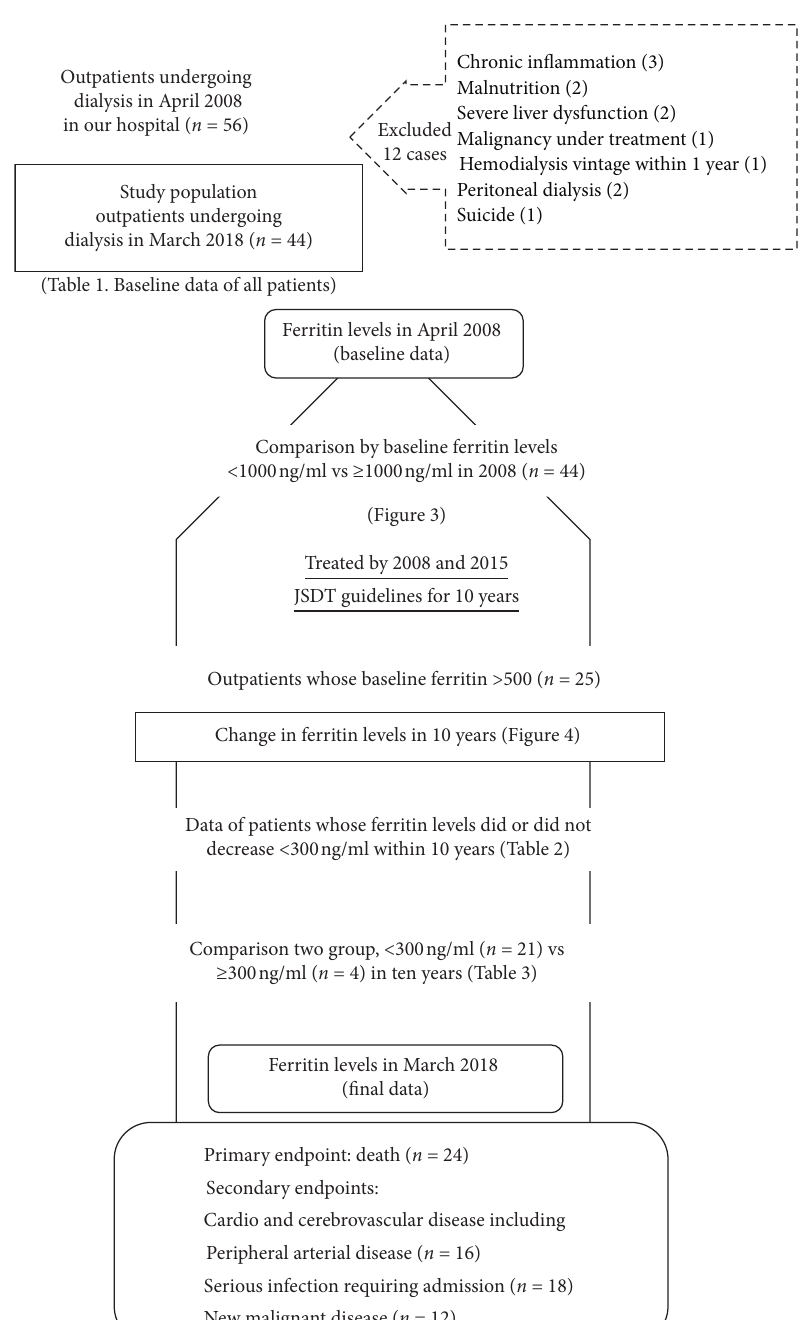
Figure 1: Study flowchart. JSDT, the Japanese Society of Dialysis